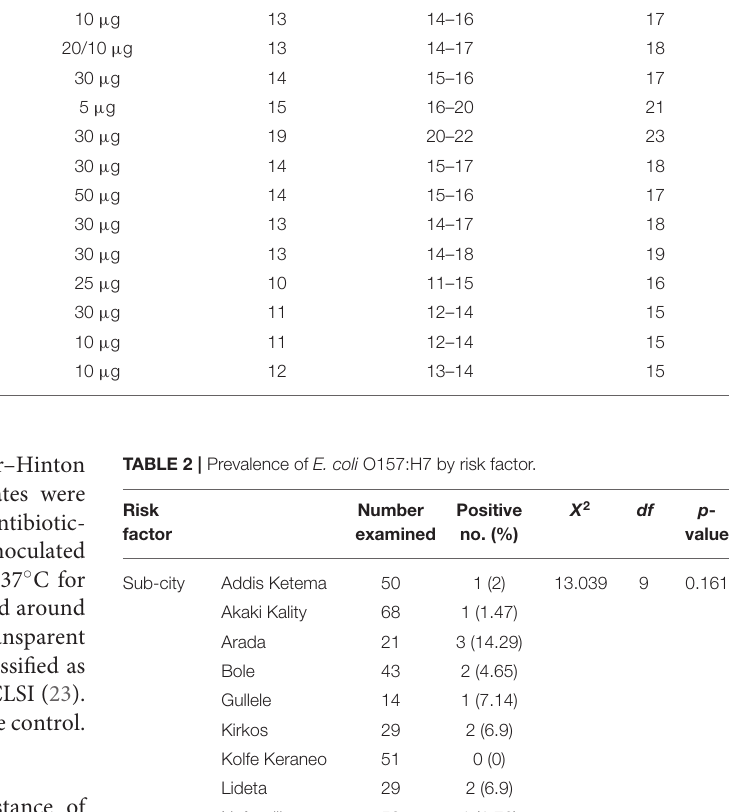
TABLE 1 | Antibiotic disks used to test E. coli O157:H7 and their respective concentrations. No.